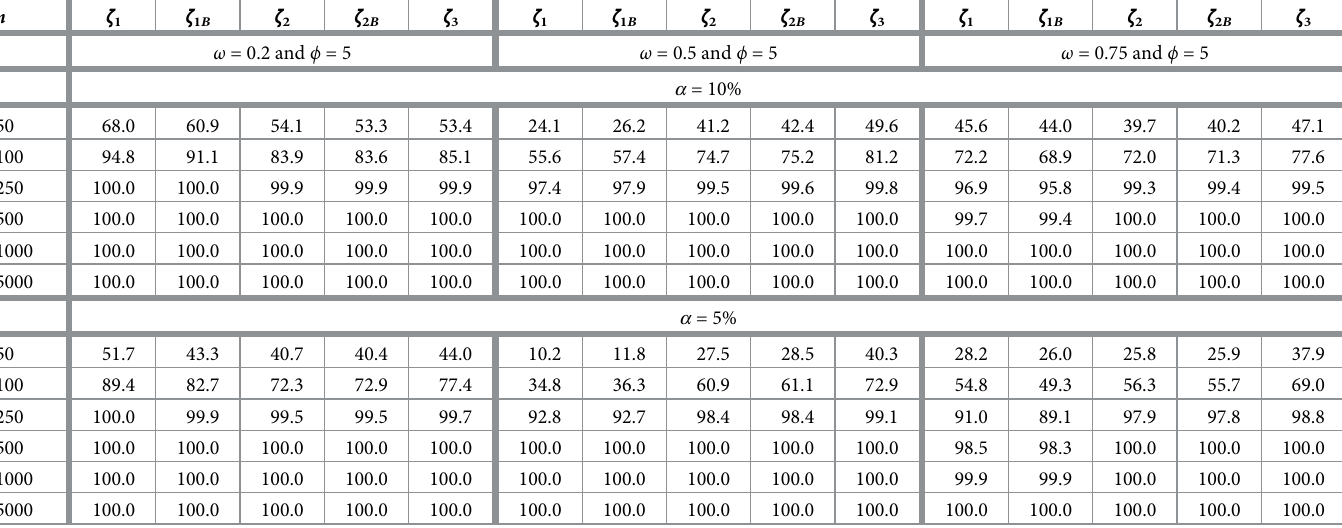
Table 5. Non-null rejection rates (%), data generated from UW ð ω ; ϕ Þ .